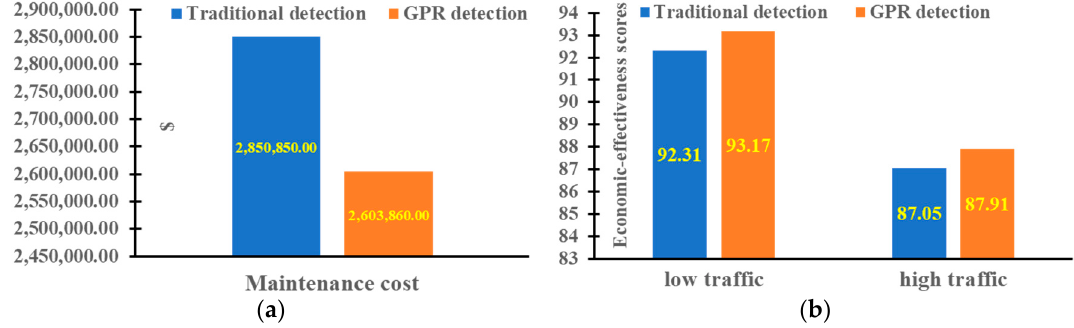
Figure 13. The contrast for maintenance cost ( a ) and economic effectiveness ( b ) of the two detecting methods. Figure 13 shows that the maintenance cost based on GPR detection was lower than that of traditional detection. More specifically, the reducing cost is $49,398/km. In addi- tion, the economic scores were higher based on GPR detection than traditional detection in low-traffic and high-traffic road sections.